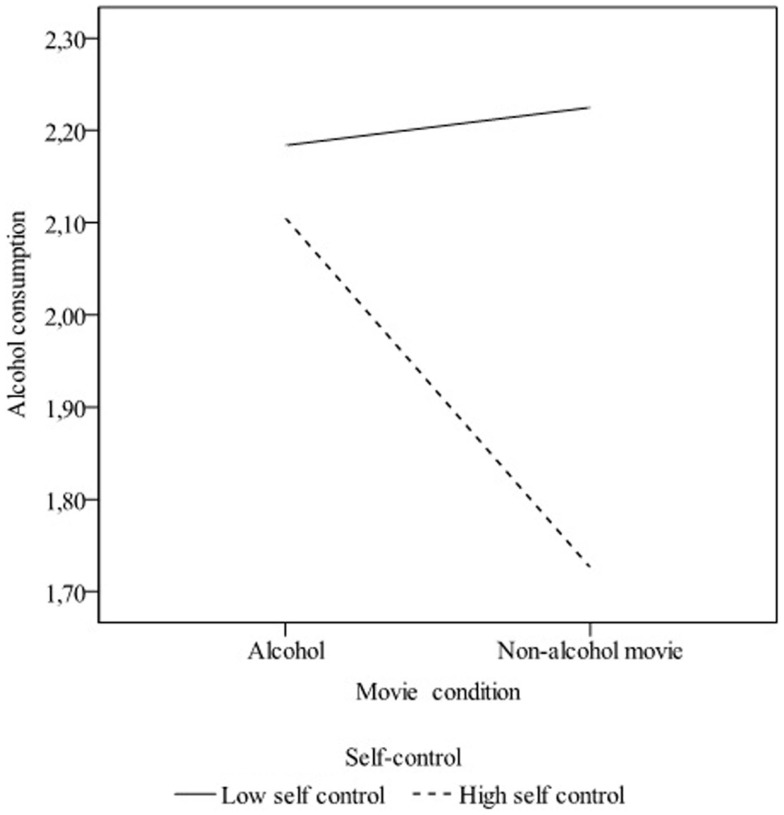
Interaction between self-control and movie condition on alcohol consumption (in glasses of 15 cl).